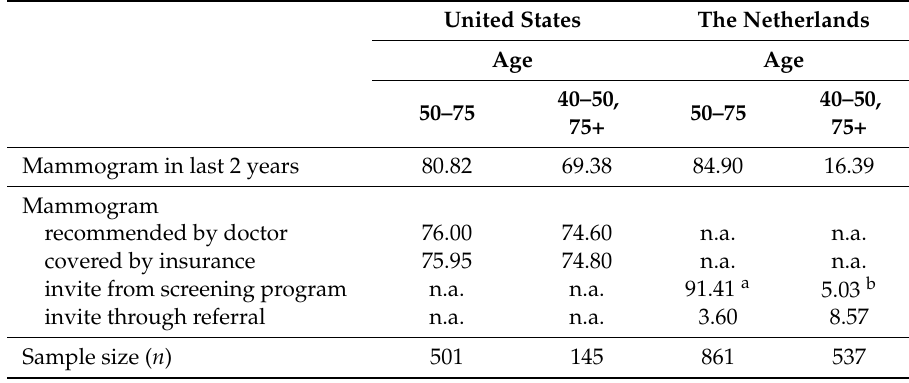
Table 1. Percentage of women receiving screening mammograms by country and age.